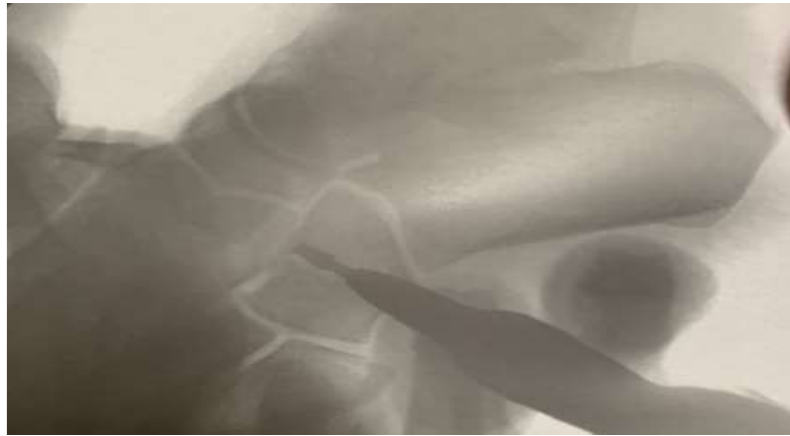
Figure 3. Cuboid view with the patient in the prone position. With the patient still in the prone position, the first metatarsal base and/or medial cuneiform dorsal closing wedge can be performed with a 12/2.2 mm Shannon burr, always making an incomplete osteotomy, also without fixation. For this procedure, an additional regional block may be necessary. A soft tissue procedure such as fasciotomy or flexor digitorum brevis tenotomy is performed at calcaneal insertion. In severe cases, tibialis posterior tenotomy is executed only at the navicular insertion, leaving the tibialis posterior spring ligament insertion intact. Weight-bearing is allowed